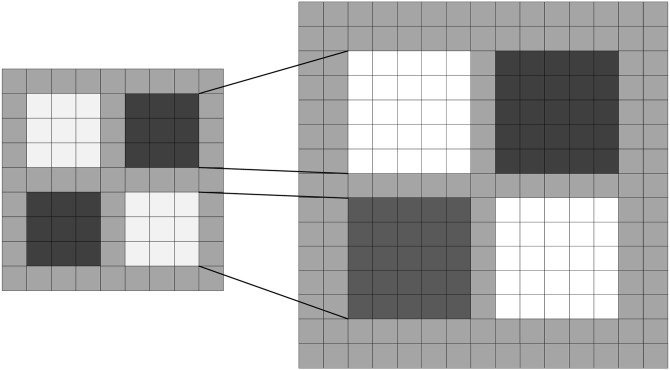
Filters Dxy for two successive scale levels (9×9 and 15×15).